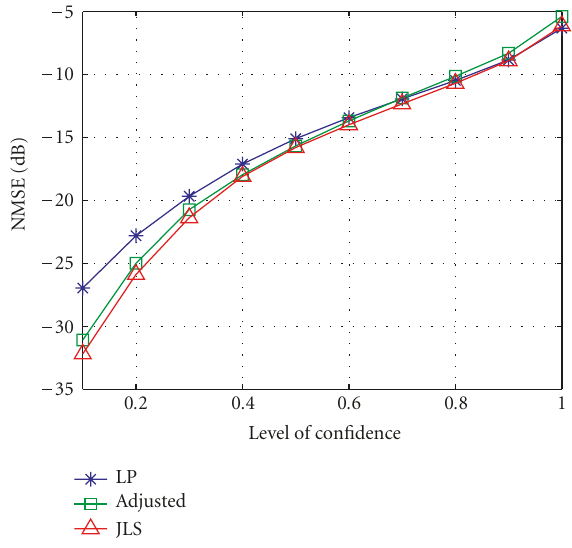
Figure 11: NMSE versus level of confidence (suburban